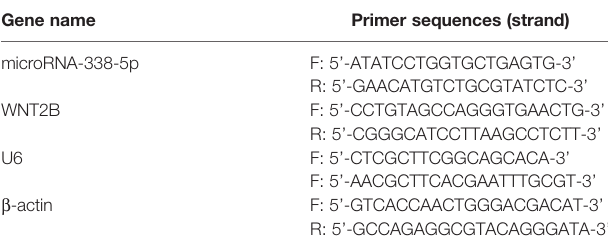
TABLE 1 | The primer sequences for Real-Time